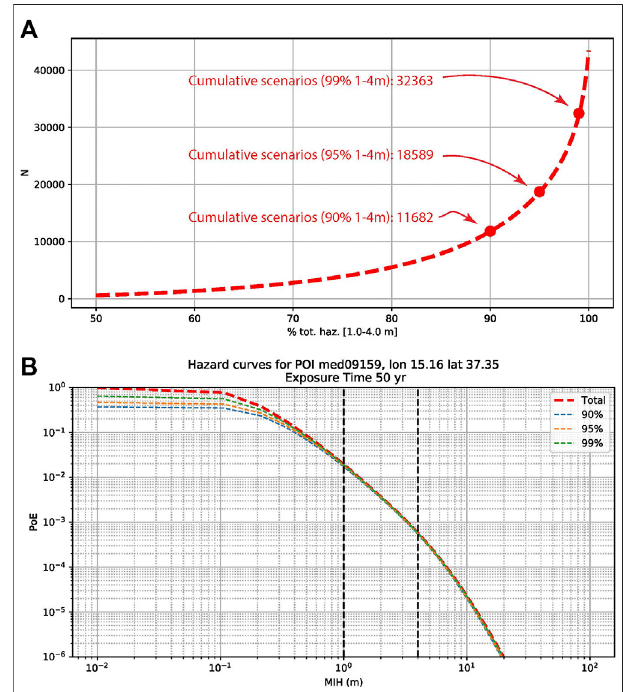
FIGURE 3 | Overview of the hazard disaggregation/scenario selection procedure (A) trade-off curve between number of scenarios contributing to the hazard at the site and percentage of hazard reproduction for the 1 – 4 m interval. The scenarios are ranked such that those contributing the most come fi rst (B) The 1 – 4 m interval hazard curve reproduced with the selected scenarios as well as the complete